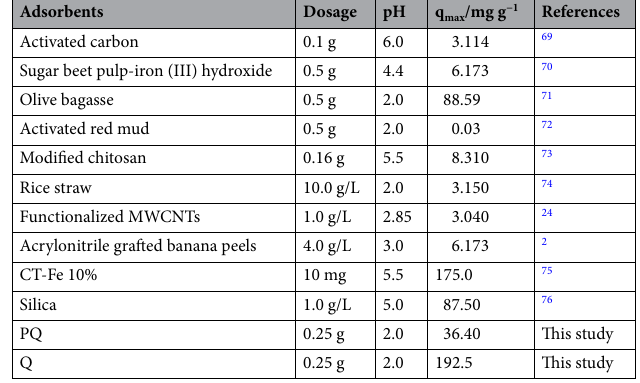
Table 4. Comparison of PQ and Q adsorbent with selected related reported works.